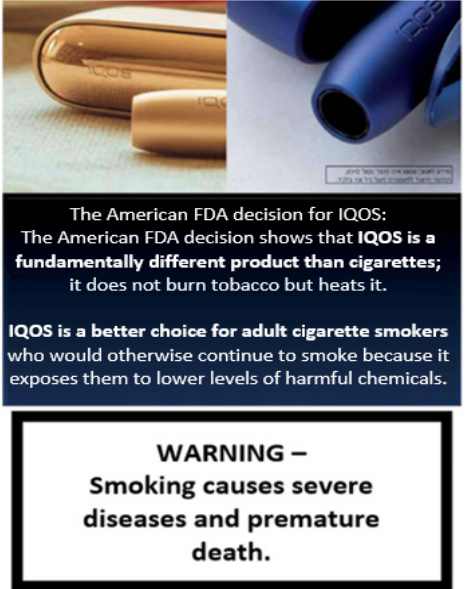
Figure 2. Use of health warning content and FDA MRTP in Israel IQOS ad (translated). Note: Ad from Israel in Spring 2021, purchased from Ifat group [81], initially in Hebrew and translated to English.